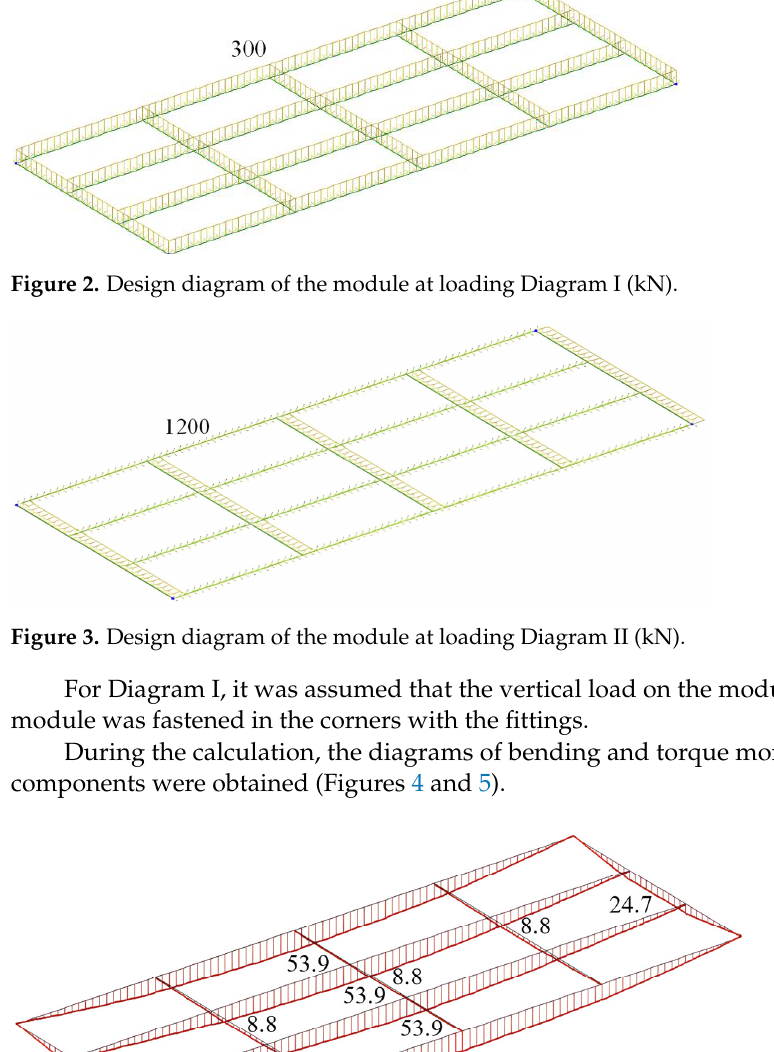
Figure 4. Diagram of the bending moments on the module (kN·m).